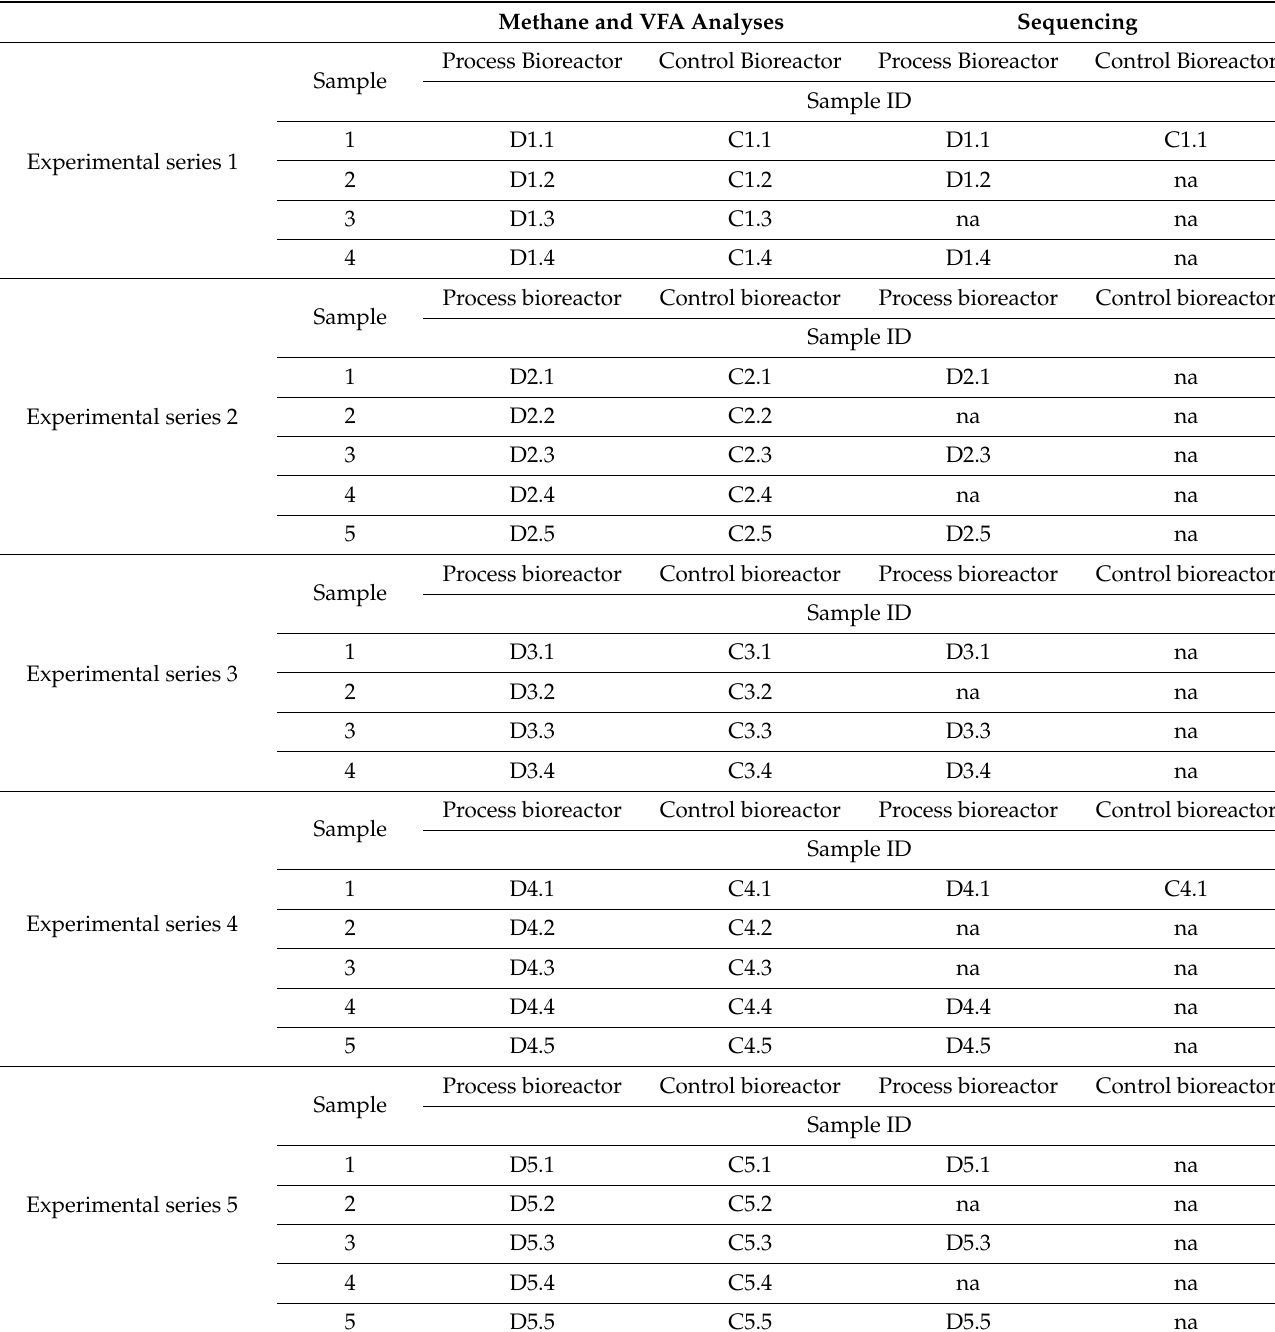
Table 2. Nomenclature for the samples used in the analyses of methane production, VFA (volatile fatty acid) content and sequencing analyses, including sample